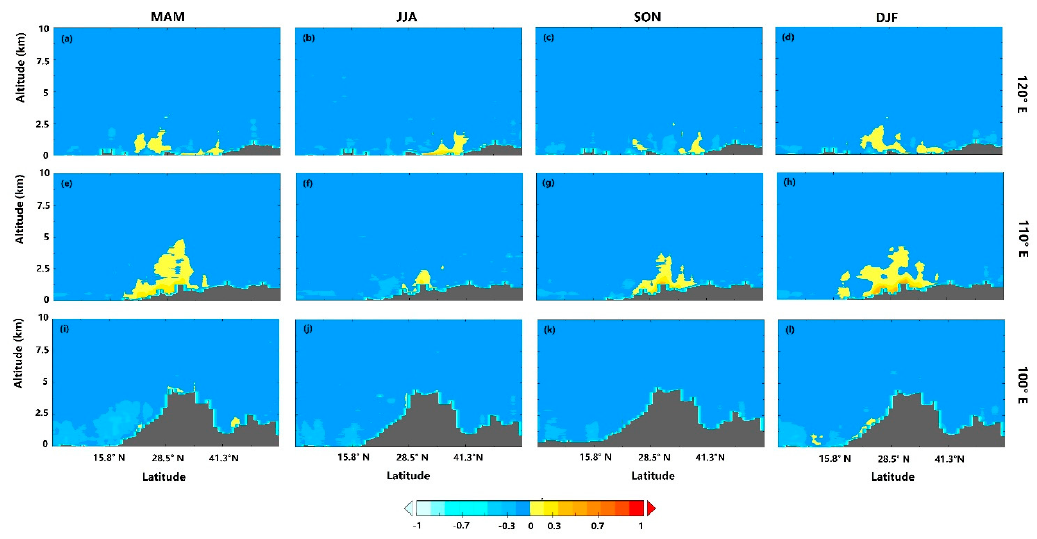
Figure 10. Cross sections of the seasonal differences of the AEC values (unit: km − 1 ) along 120 ◦ E, 110 ◦ E and 100 ◦ E of RAMS-CMAQ and CALIOP.